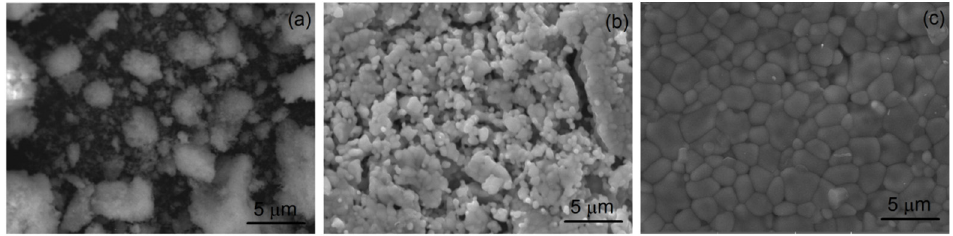
Figure 5. SEM micrographs of the samples: ( a ) HT700; ( b ) HT800; ( c ) HT900.